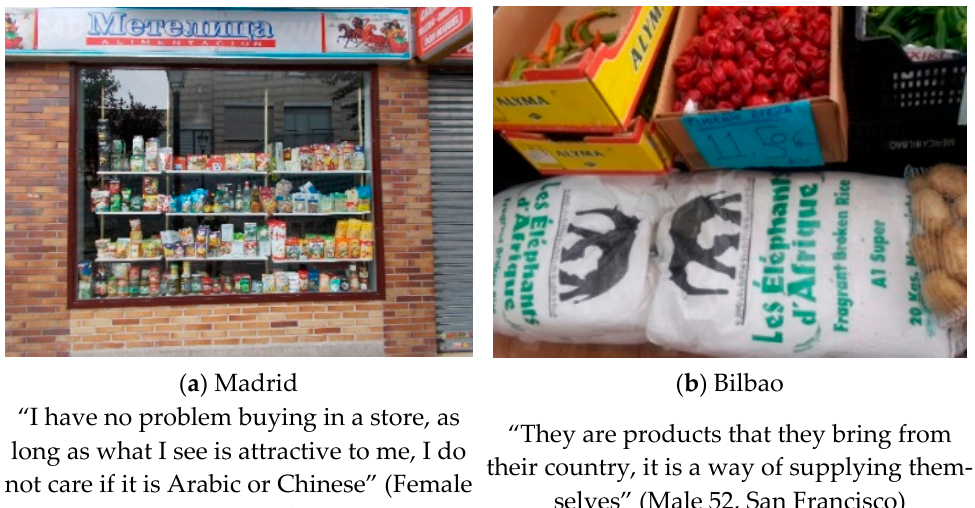
Figure 2. ( a ) Photograph made in Madrid: “Storefront”. Category: food variety. Theme: Cultural Diversity; ( b ) Photograph made in Bilbao: “Elephant products”. Category: Supply. Theme: Multi-culturalism.